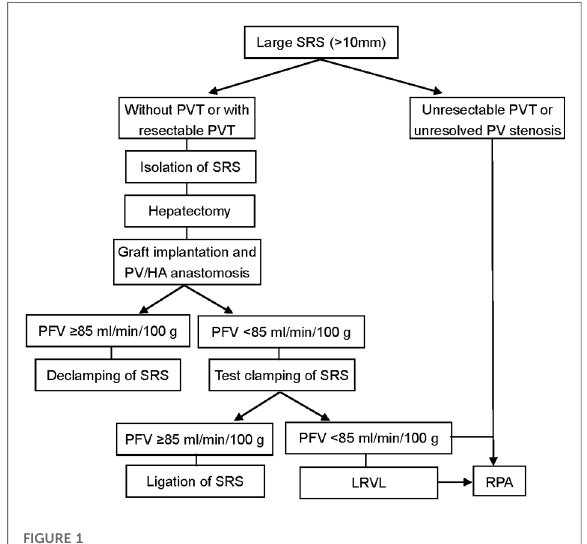
FIGURE 1 Flowchart for SRS ligation surgery